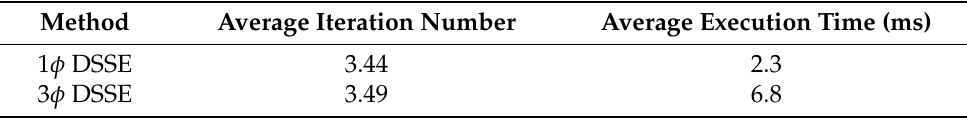
Table 1. Comparison of computational times in Case